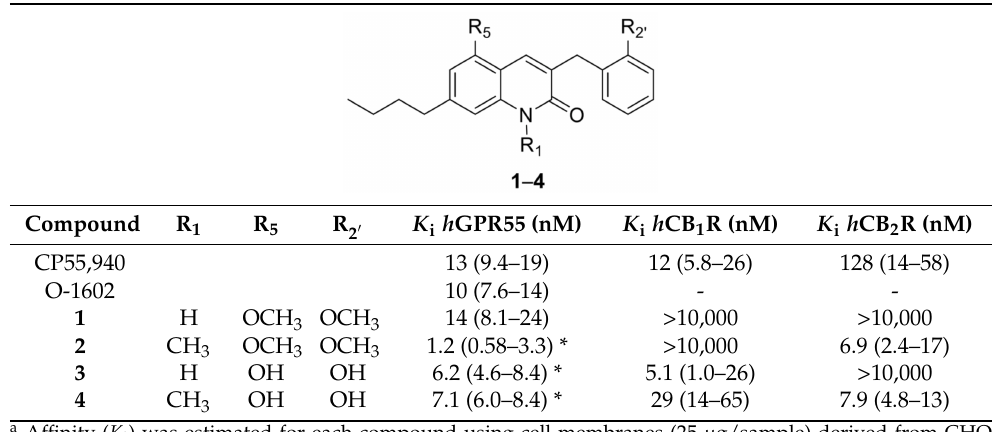
Table 1. Radioligand binding assays on h GPR55 and h CBRs a